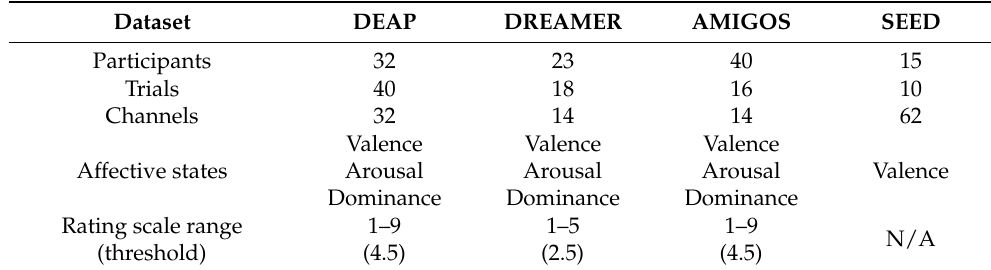
Table 1. Comparison between datasets.